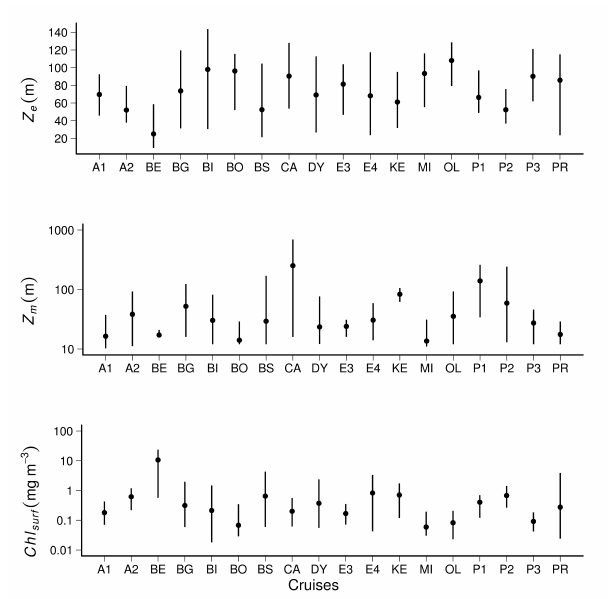
Fig. 3. General characteristics of the dataset used in this study. Range (line) and mean values (circle) of Z e (m), Z m (m) and Chl surf (mgm − 3 ) for the 18 Cruises. See Table 2 for abbreviations of the different